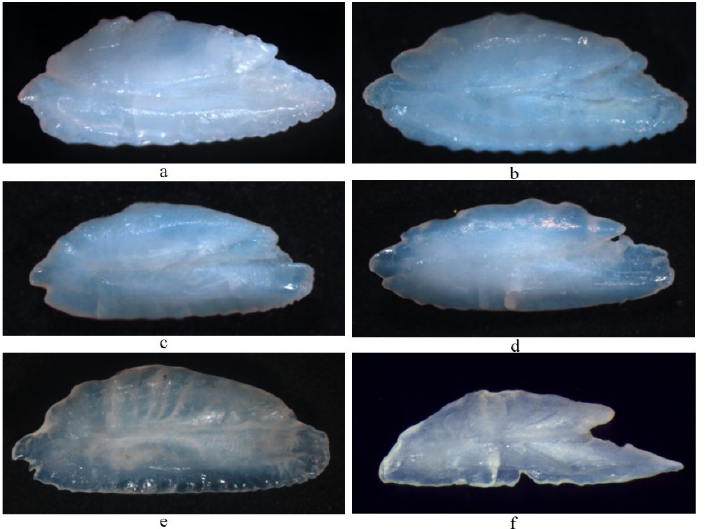
Figure A2. Morphology of otolith of six hairtail species. Note: ( a ), T. japanicus ; ( b ), T. nanhaiensis ; ( c ), T. brevis ; ( d ), L. savala ; ( e ), E. muticus ; ( f ), Te. Cristatus .